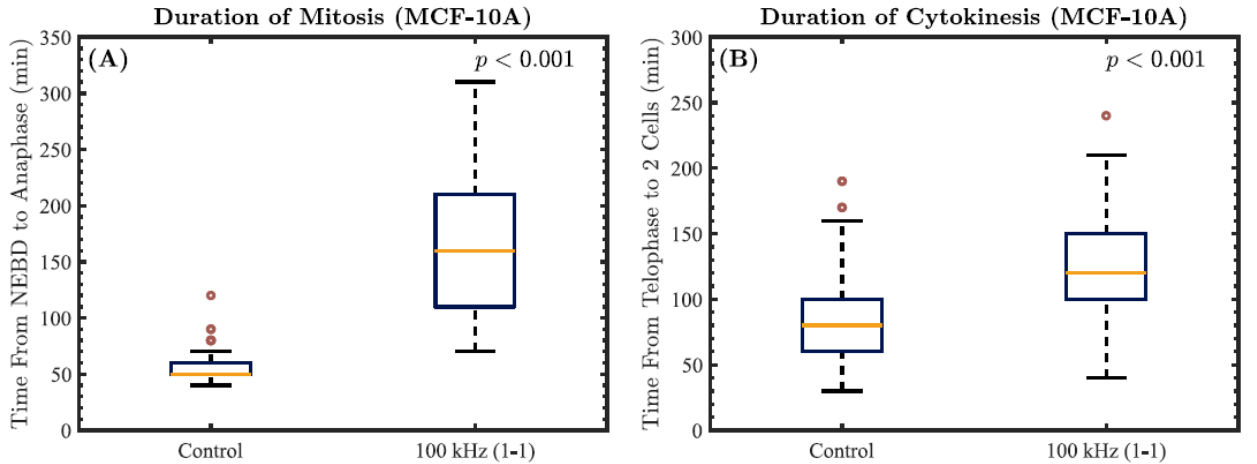
Figure 8. The durations of mitosis and cytokinesis obtained from our experiments with MCF-10A cells. The p -value overlaid on each plot corresponds to the results obtained from each two-sample t -test comparing the displayed data for MCF-10A cells in the TTFields-exposed group to those of the control cells. ( A ) Boxplots representing the duration of mitosis, calculated from nuclear envelope breakdown (NEBD) to anaphase. ( B ) Boxplots representing the duration of cytokinesis, calculated from telophase to the formation of two separated daughter cells. Data are displayed as the median duration flanked by upper and lower quartiles, with outliers shown as red